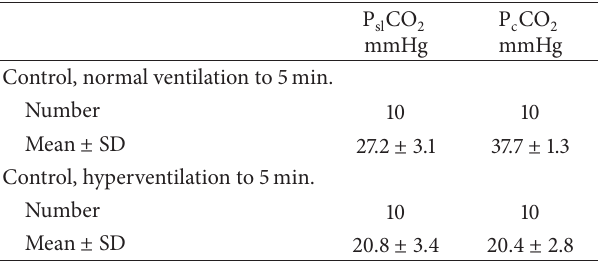
Table 3: Testing under hyperventilation in healthy volunteers.